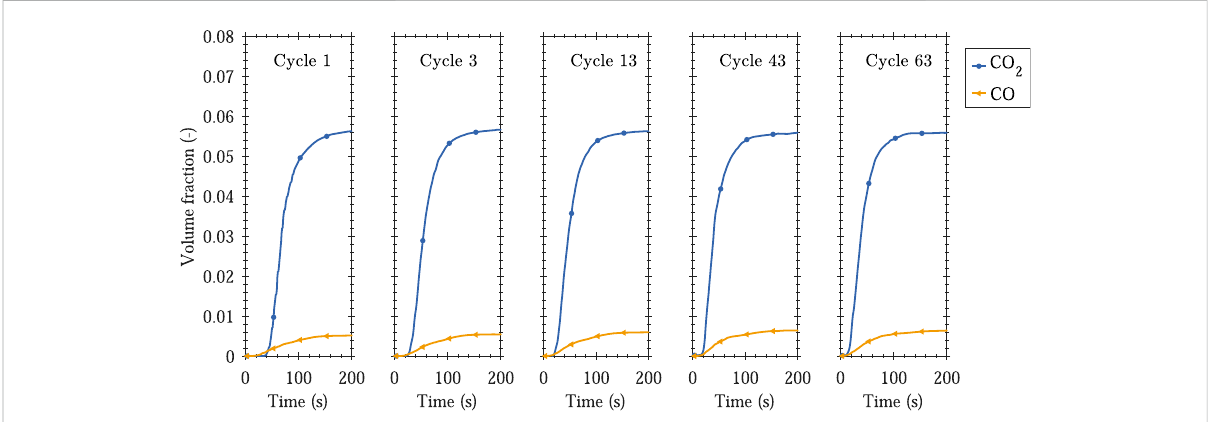
FIGURE 7 Experimental breakthrough curves (dry volume fraction) of CO 2 and CO for adsorption cycles 1, 3, 13, 43, and 63 on K-HDMO sorbent and Cu/ ZnO/Al 2 O 3 catalyst. Sorbent mass: 9.35 g, catalyst mass: 0.51 g, temperature: 250 ° C, pressure: 8 bar, feed composition: 0.05/0.2/0.75 CO/H 2 O/N 2 . Regeneration pressure:1 bar, regeneration feed composition: 0.4/0.6 H 2 O/N 2 . Catalyst is homogeneously mixed with sorbent material in the fi rst quarter of the